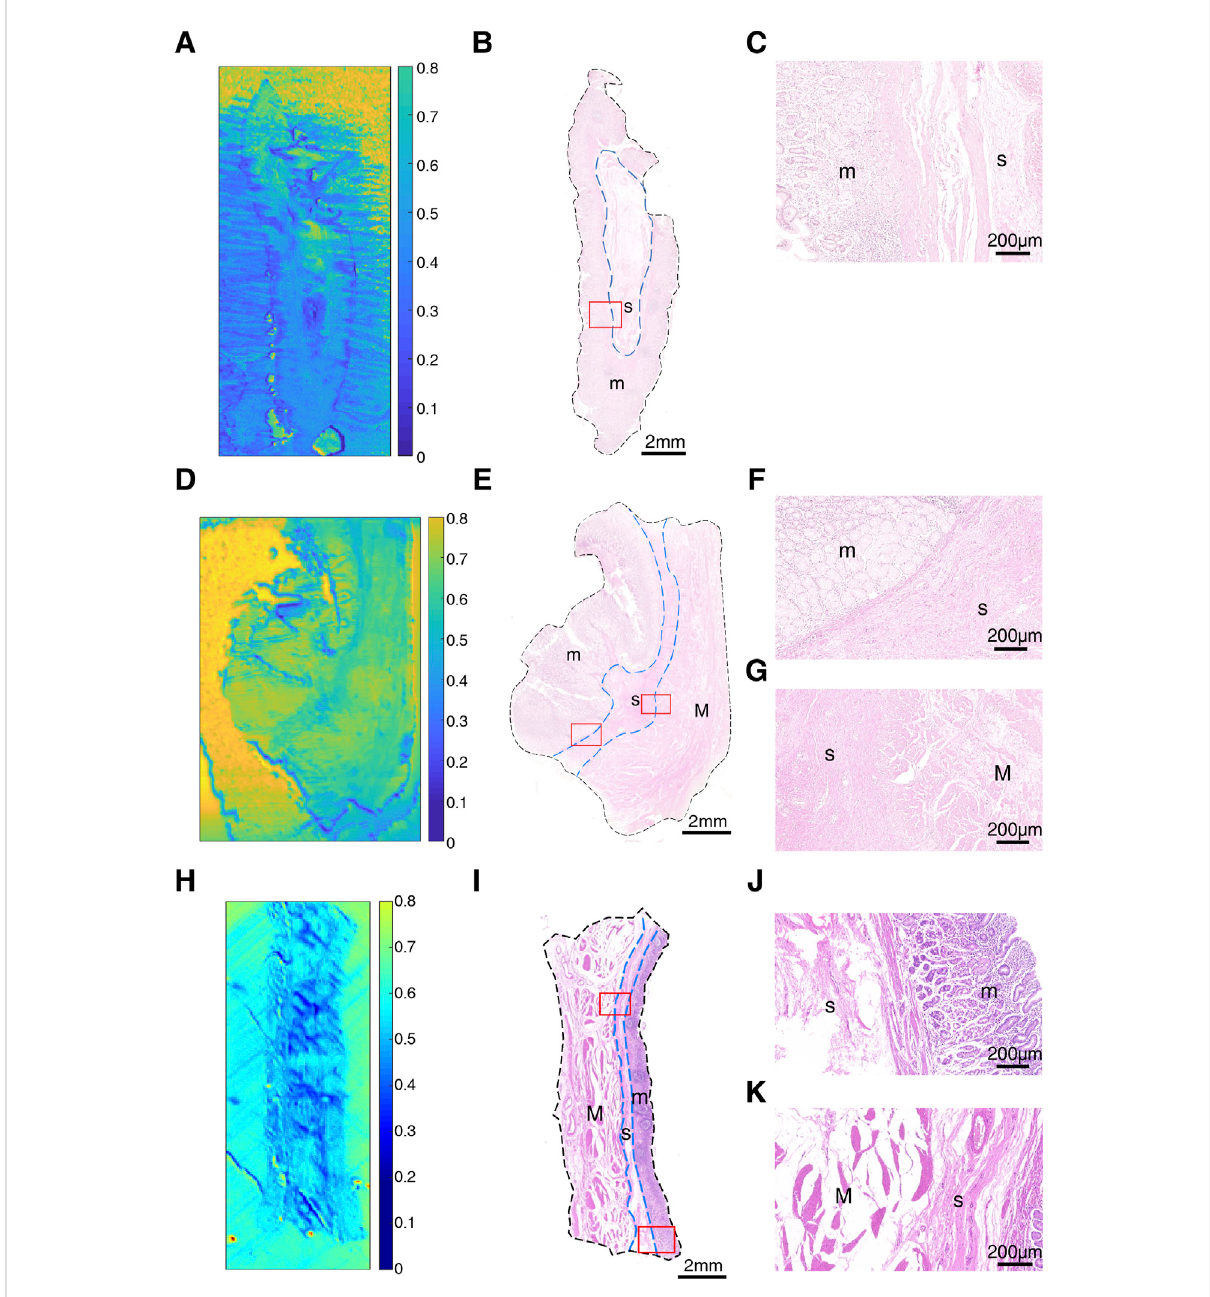
FIGURE 2 Images of non-tumorous adjacent tissue: (A) THz image, (B) H&E-stained slice, and (C) H&E-stained image corresponding to the region indicated by the red square in (B) of N1; (D) THz image, (E) H&E-stained slice, and (F,G) H&E-stained images corresponding to the region indicated by the red square in (E) of N2; (H) THz image, (I) H&E-stained slice, and (J,K) H&E-stained images corresponding to the region indicated by the red square in (I) of N3. In H&E-stained images, “ m ” indicates “ mucosa ” , “ s ” indicates “ submucosa ” and “ M ” indicates “ muscular layer ” . In (B,E,I) , the boundaries of mucosa, submucosa and muscular layer are outlined with dashed blue lines. (C,F,J) are boundaries between mucosa and submucosa. (G,K) are the boundaries between submucosa and muscular